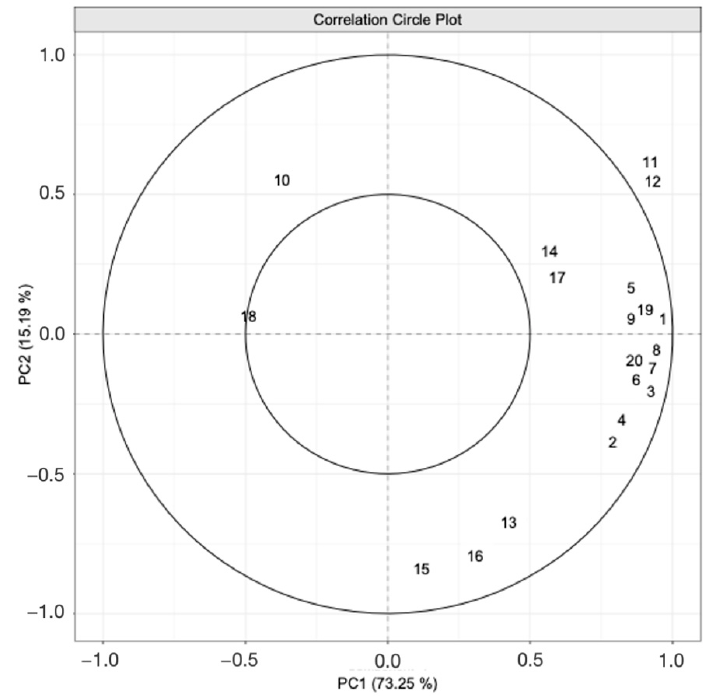
Figure 3. Correlation circle plots from the PCA applied to GC/MS data. Correlation circle plots display the correlation structure between compounds produced throughout fermentation in the space spanned by PC1 and PC2. The numbers represent the name of the compound displayed in Table 4.